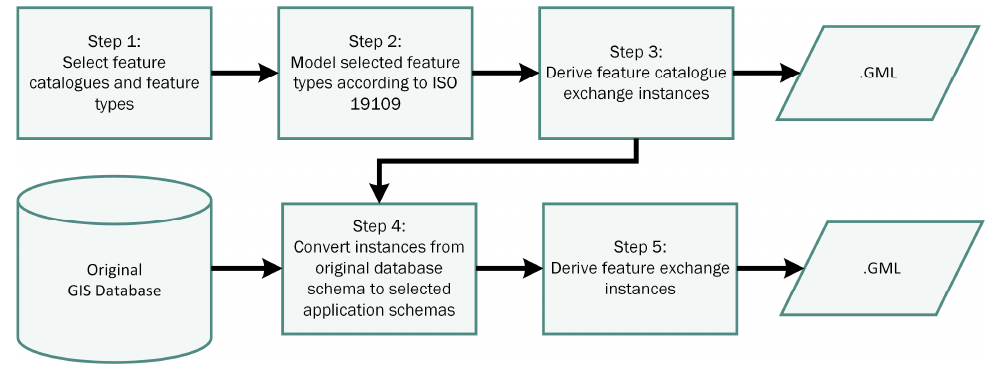
Figure 8. Steps in the case study.